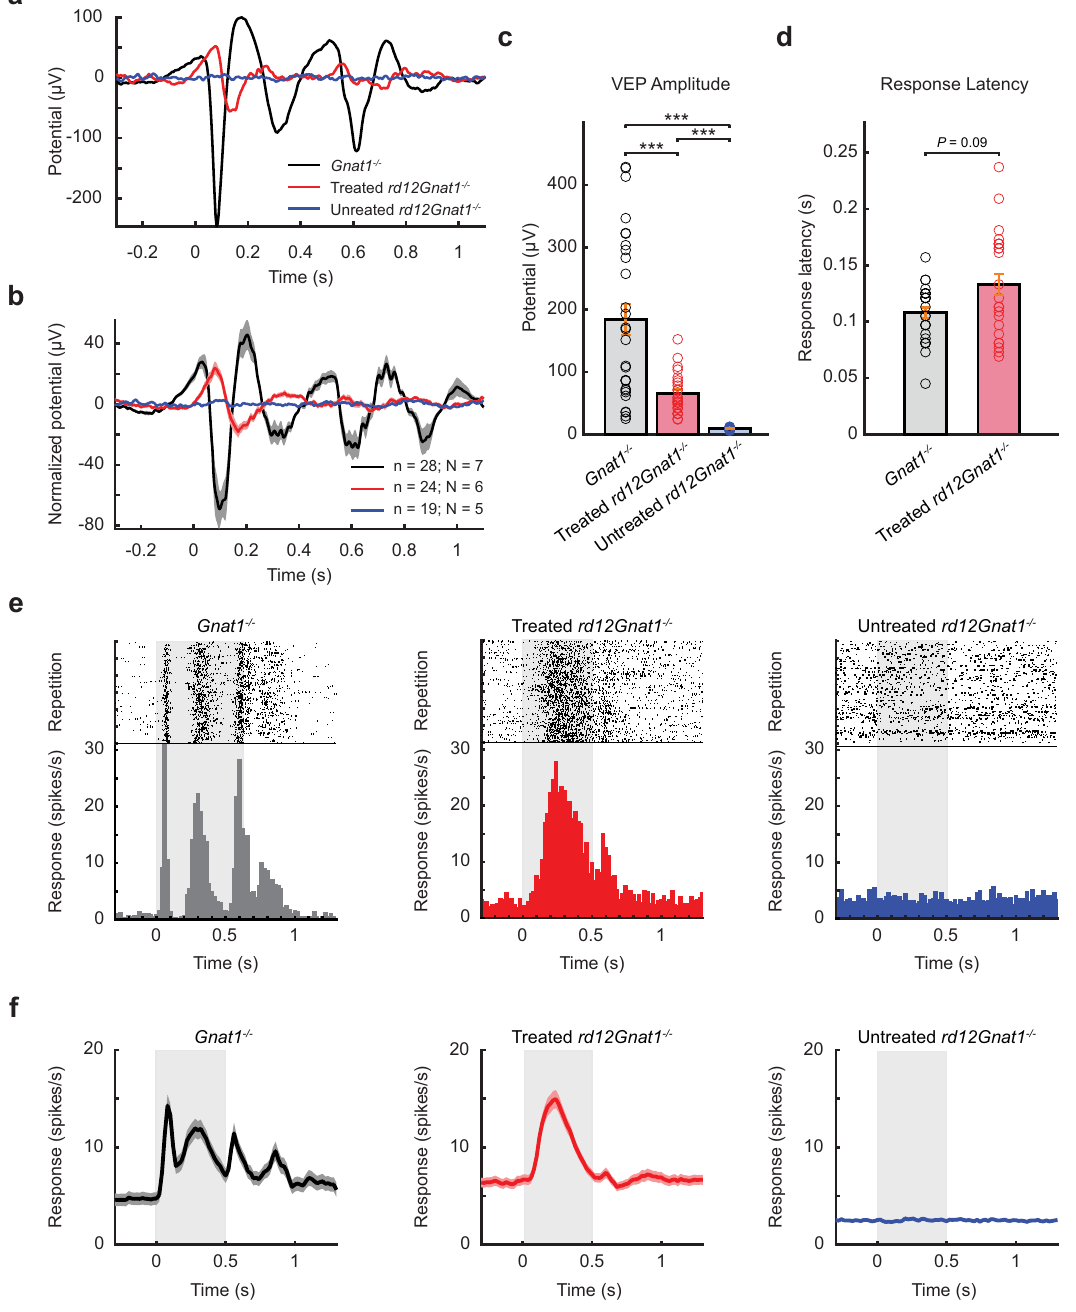
Fig. 4 ABE treatment restores the visual pathway from cones to the visual cortex. a Representative visually evoked potentials (VEPs) from control Gnat1 − / − , treated rd12Gnat1 − / − , and untreated rd12Gnat1 − / − mice. b Population average of VEPs recorded from three groups in a . N total number of mice, n total number of recording sites from each experimental group. Shading indicates SEM. c VEP amplitudes recorded from three groups. Mean ± SEM. *** P < 0.001; two-tailed Mann – Whitney U -test. P values are 0.0004 for Gnat1 − / − vs. treated rd12Gnat1 − / − and <0.00001 for other comparison groups. d Response latencies of VEPs recorded from two groups. Mean± SEM. Two-tailed Mann – Whitney U -test. e Raster plots and corresponding histograms for single neurons in Gnat1 − / − ( n = 387 cells), treated ( n = 286 cells), and untreated rd12Gnat1 − / − ( n = 121 cells) mice, respectively. f Population average histograms for the same groups as e . Shading indicates SEM. Source data are provided as a Source data fi le. region, respectively, and 25% (vs. 5% in untreated) and 17% (vs. 0.2% in untreated) of S-opsins in the dorsal and ventral region (Supplementary Fig. 6c, d). We also observed that both M-opsins and S-opsins were correctly localized to the cone outer segments in the treated rd12Gnat1 − / − mice on retinal cryosec- tions (Fig. 5e). NATURE COMMUNICATIONS| (2022) 13:1830